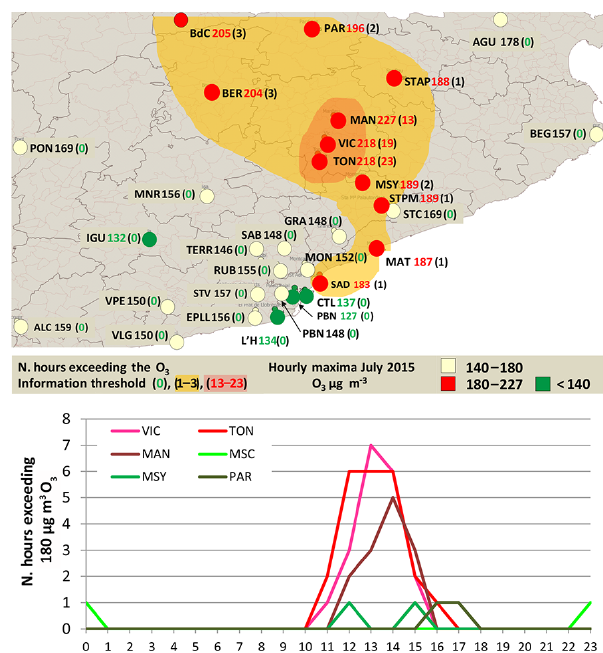
Figure 9. Top: hourly O 3 maxima (and number of hours exceed- ing 180µgm − 3 ) in the study sites with real-time O 3 measurements (shadowed areas indicate two different degrees of exceedances, 1–3 and 13–23h). Bottom: frequency of occurrence of hourly (UTC) O 3 exceedances of 180µgm − 3 along the day; both for July